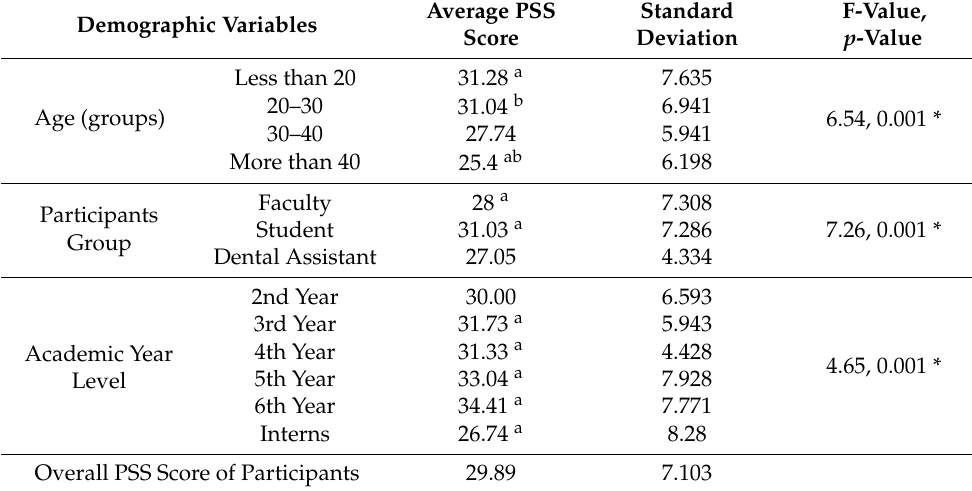
Table 3. Showing the average PSS scores of the participants involved in our